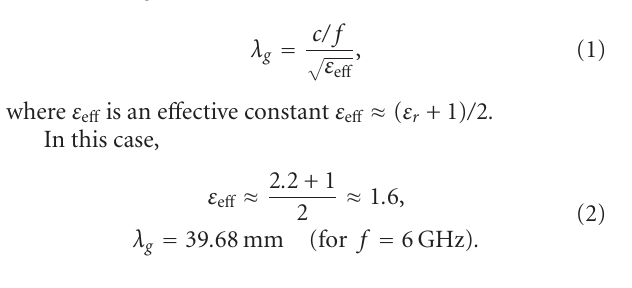
layer of dielectric substrate (RT/duroid 5880 PTFE glass fiber